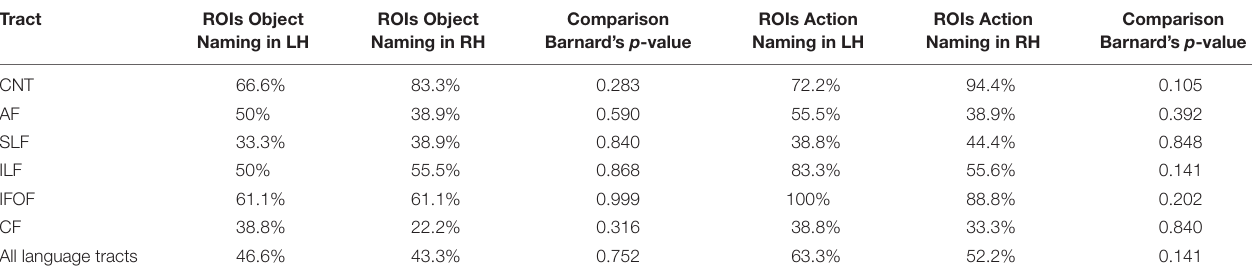
TABLE 3 | Percentages of participants with visualized tracts (with Barnard’s test comparison between hemispheres for ROIs in the LH and RH). Tract